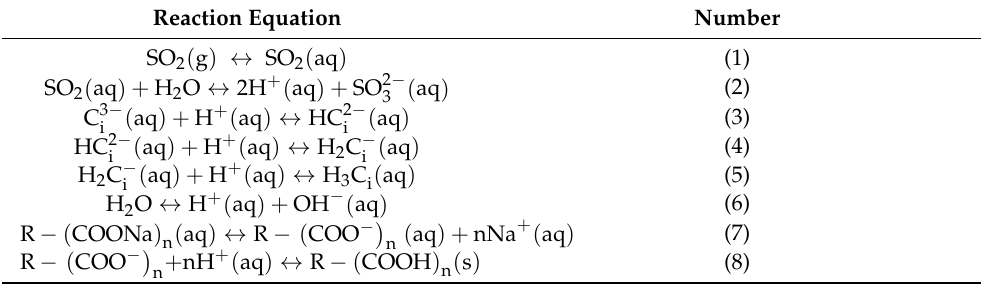
Table 1. The reaction equation of CO 2